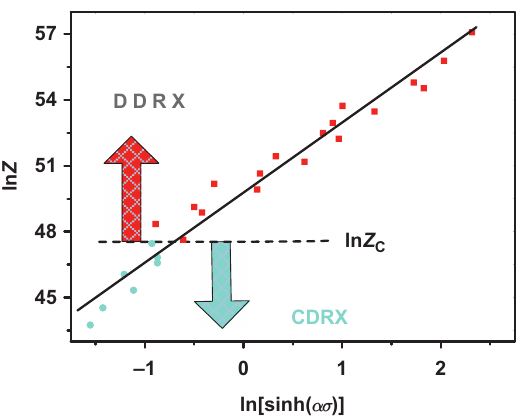
Figure 5: The distribution trend of Zener – Hollomon parameter. The ln Z values can be divided into two parts by the critical value ln Z C : the DDRX and CDRX.